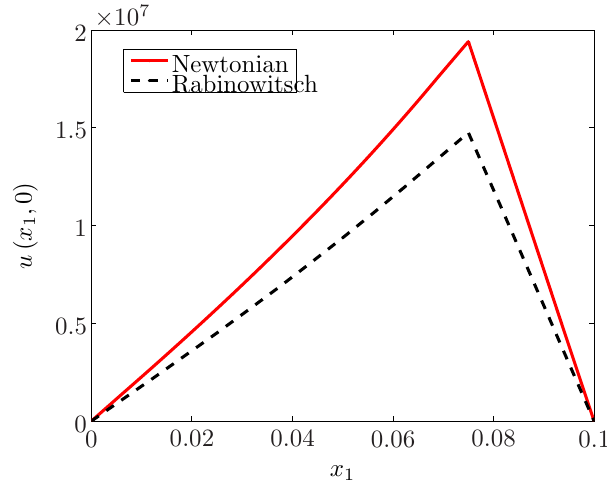
Figure 4. Homogenized Newtonian and non-Newtonian pressure solutions along the line x 2 =